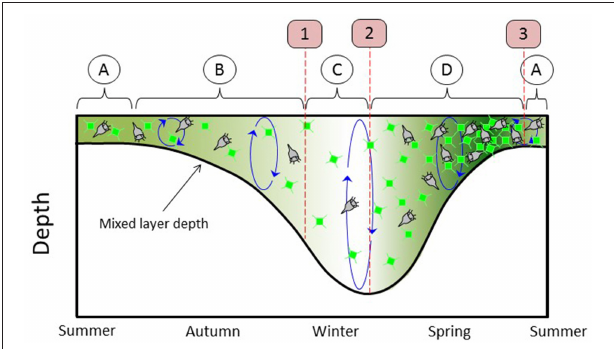
FIGURE 1 | Stylized annual plankton cycle, beginning on left in midsummer and ending in early summer. Thick black line = mixed-layer depth (MLD). Green phytoplankton cells and green shading represent phytoplankton concentration. Gray ciliates stand for all phytoplankton predators. Circled A = summer condition of near-equilibrium between phytoplankton division and loss rates. Circled B = depletion phase. Circled C = phase where division exceeds loss but MLD is still deepening, phytoplankton concentrations are stable or decreasing, and phytoplankton biomass integrated over MLD is increasing. Circled D = accumulation phase. Boxed 1 = winter transition. Boxed 2 = transition to increasing phytoplankton concentration. Boxed 3 = climax